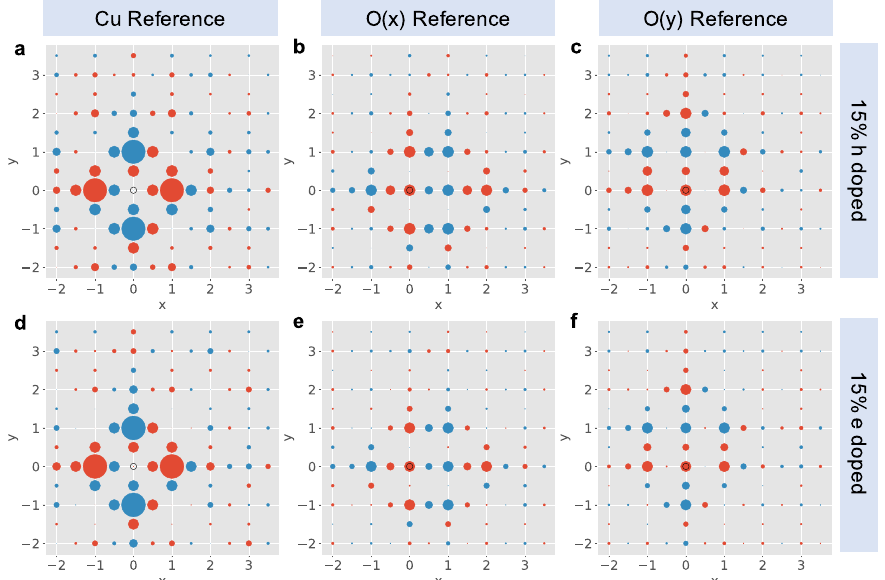
Fig. 2 Pairing structure of the three-band model. The real-space components of the leading particle – particle BSE (symmetrized) eigenvector for the three-band model at optimal doping and β = 10 eV − 1 on a 6 × 6 cluster. Each column describes the pairing between a Cu-d (or O p x , p y ) reference site and all other orbitals as a function of distance. All panels set the Cu- d orbital at the origin, as